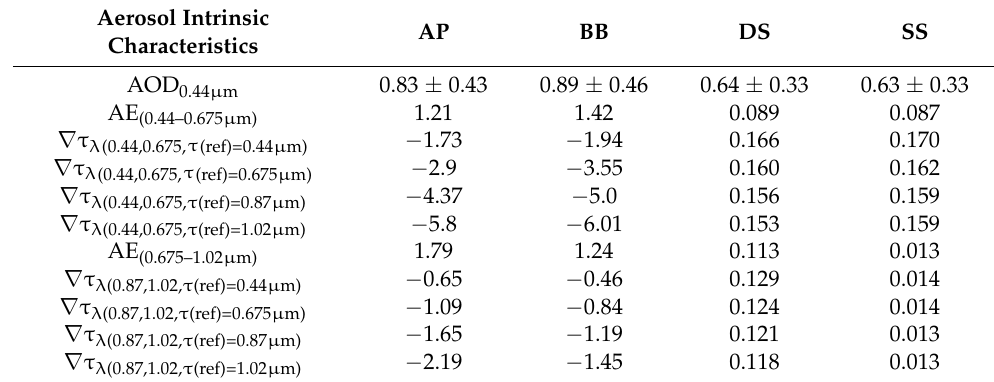
Table 3. The optical characteristics of anthropogenic pollutant (AP), biomass burning (BB), dust (DS), and sea salt (SS) from the 6S simulations using experimental datasets. Aerosol Intrinsic